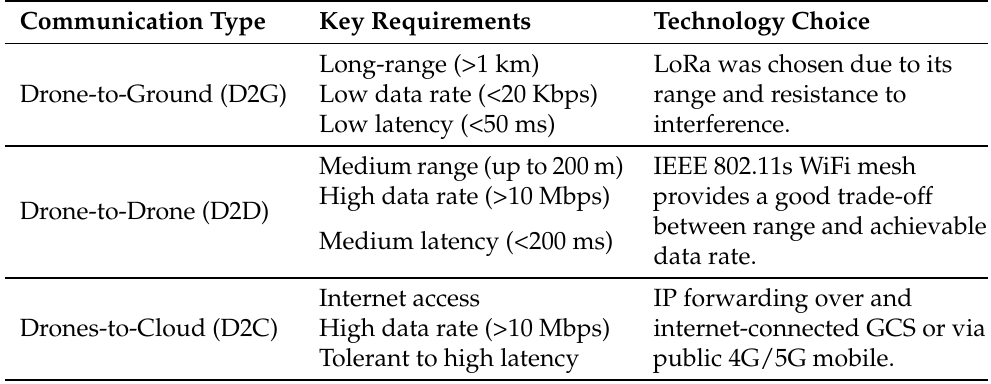
Table 2. Selected communication technologies for the UAS design